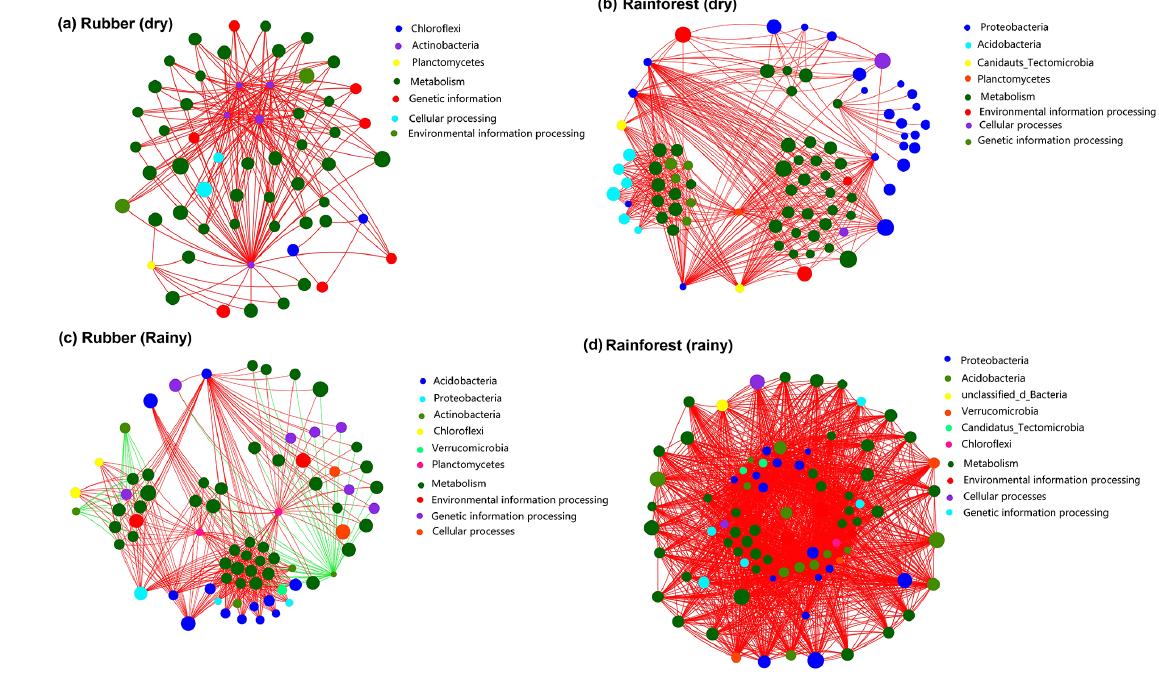
Figure 8. Network of the top 50 most abundant species (based on metagenomics data) and the top 50 most frequent KEGG functions (pathway level 3) of rubber plantation and tropical rainforest sites in the dry and rainy seasons: panel (a) shows rubber in the dry season, panel (b) shows rainforest in the dry season, panel (c) shows rubber in the rainy season and panel (d) shows rainforest in the rainy season. The size of the node indicates the species/function abundance. A red line indicates a positive correlation between species/functions, and a green line indicates a negative correlation. The absolute value of the correlation coefficient > 0 . 6 ( P < 0 .